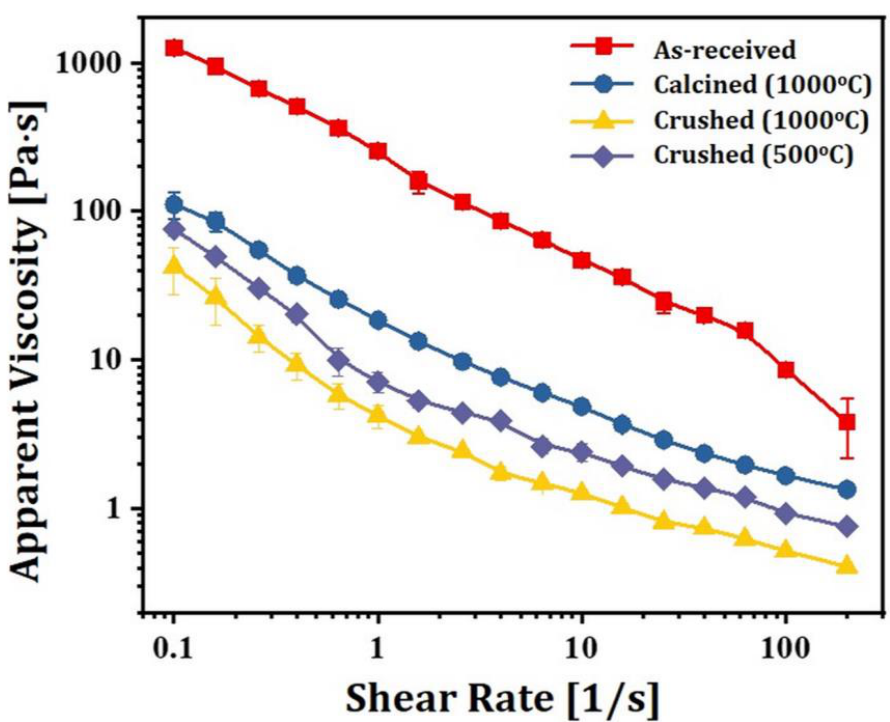
Figure 6. Apparent viscosities as a function of shear rate observed for 5Y-PSZ suspensions prepared using as-received, granule calcined at 1000 °C, and crushed particles obtained via ball-milling of granules calcined at 1000 °C and 500 °C (solid loading = 44 vol%).